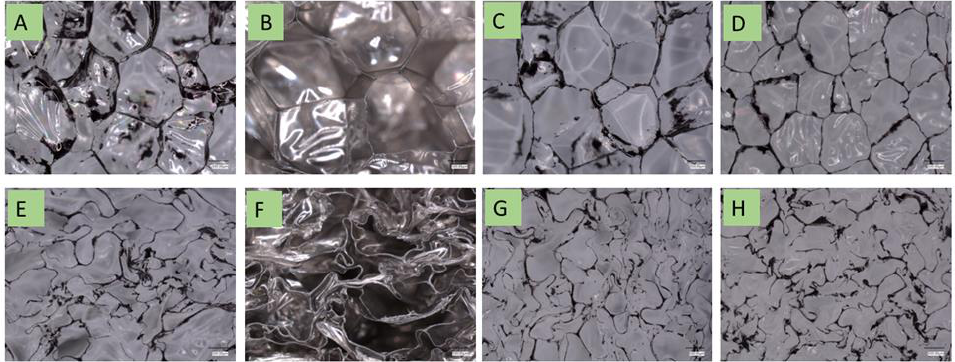
Figure 3. Typical images of the initial foams: ( A ) D16, ( B ) D21, ( C ) D30 and ( D ) D36; and the auxetic foams: ( E ) PE-D16-P1.5, ( F ) PE-D21-P1.9, ( G ) PE-D30-P2.0 and ( H ) PE-D36-P1.5.